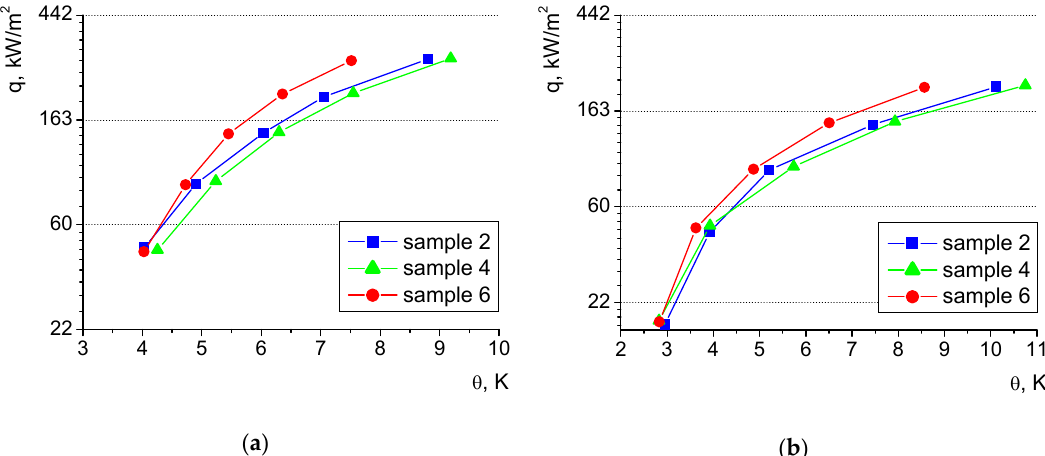
Figure 9. Boiling curves of samples of various ratio of surface area textured with laser to the total surface area (groove depth, 0.25 mm); ( a ) distilled water, ( b ) ethyl alcohol.